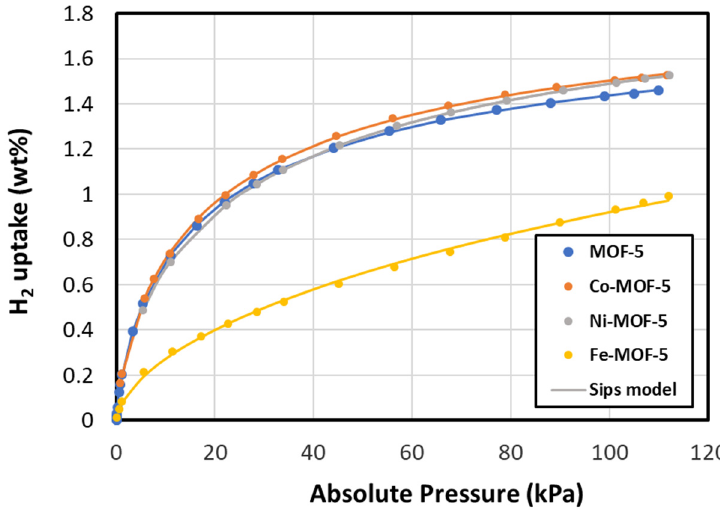
Figure 8. Hydrogen adsorption isotherms at 77K of MOF-5 and M-MOF-5 (experimental circles) and the Sip model (continuous line). Table 3. Hydrogen adsorption uptakes (at 77 K and 110 kPa) and the Sips model parameters of MOF-5 and M-MOF-5.